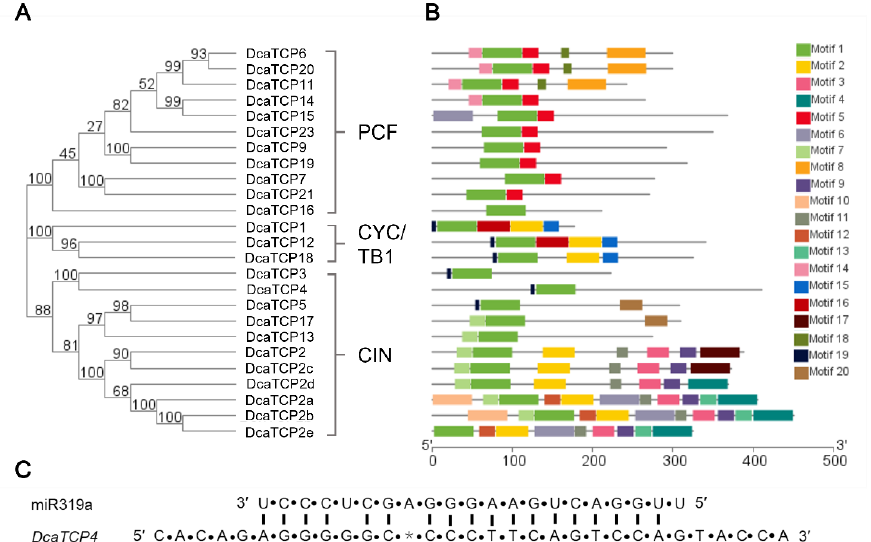
Figure 2. Genomic structure and motif composition of D. catenatum TCPs. ( A ) Phylogenetic tree of D. catenatum TCP proteins. ( B ) The conserved motifs in D. catenatum TCP proteins were identified using MEME. Each motif is represented with a specific color. ( C ) Alignment of putative target area for miR319a (aligned in reverse).